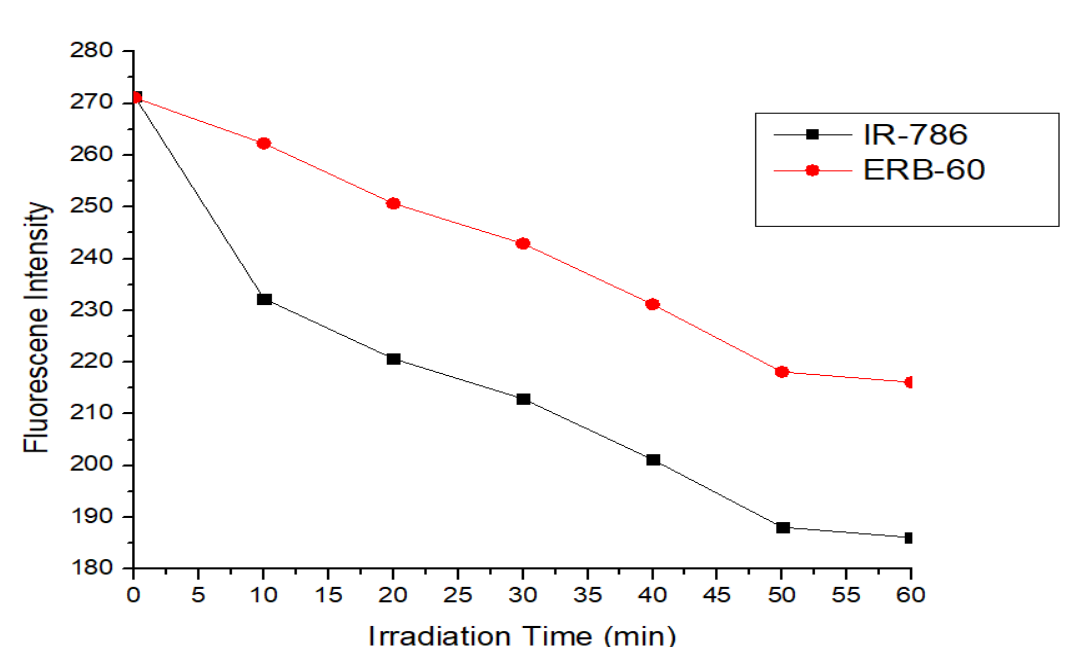
Figure 4. Photostability studies of ERB-60 under continuous irradiation with a Xenon lamp at 150W for 1 h. The rate of photobleaching of ERB-60 was determined based on the reduced fluorescence intensity from 270 upon continuous irradiating with light (excitation wavelength, 790 nm). A commercially available dye, IR-786 iodide, was used as a reference.